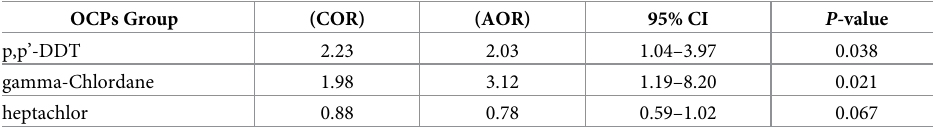
Table 5. Findings from multivariate logistic regression model.